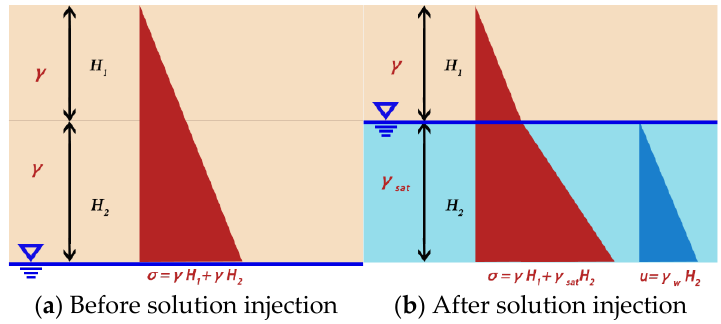
Figure 1. Slope models before and after solution injection.